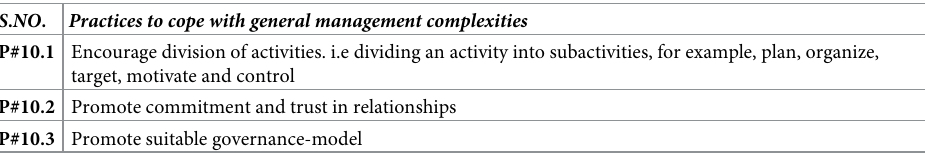
Table 13. Practices to cope with general management complexities in